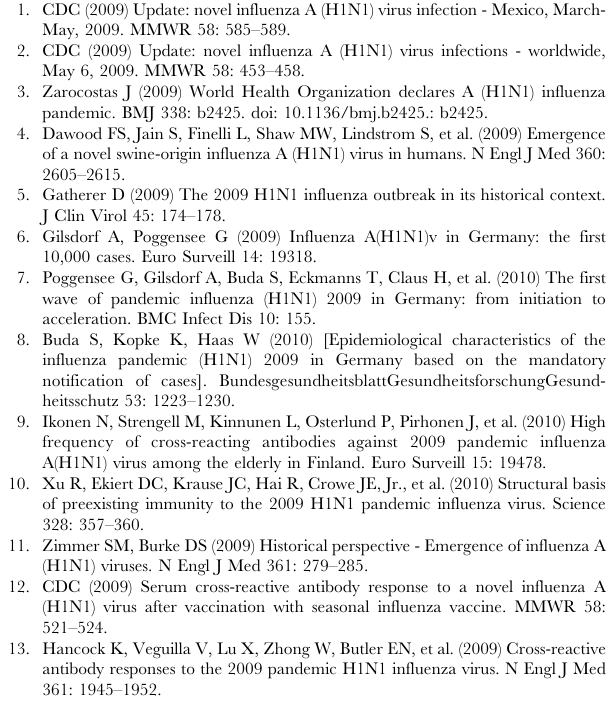
Table S4 Number and proportion of observations with reactive antibody titre $ 40 by three birth cohorts in pre-pandemic and post-pandemic samples and difference in proportions between pre-